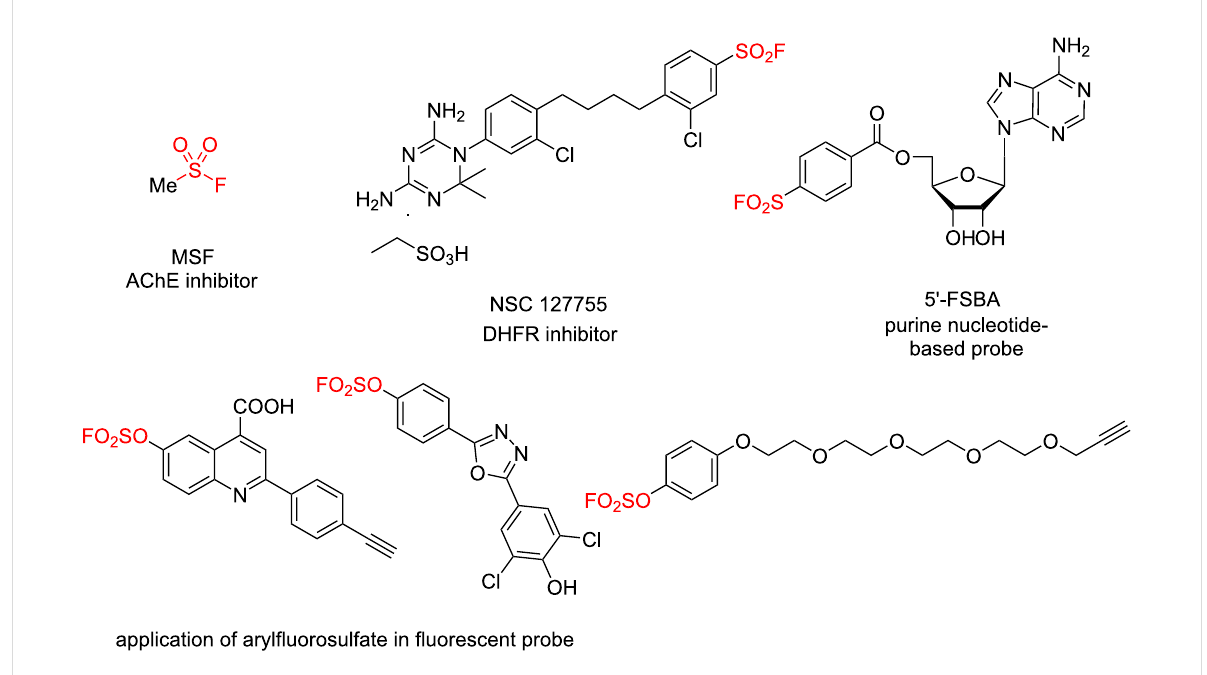
Figure 1: Representative sulfonyl fluoride compounds applied in medicinal chemistry and chemical biology.